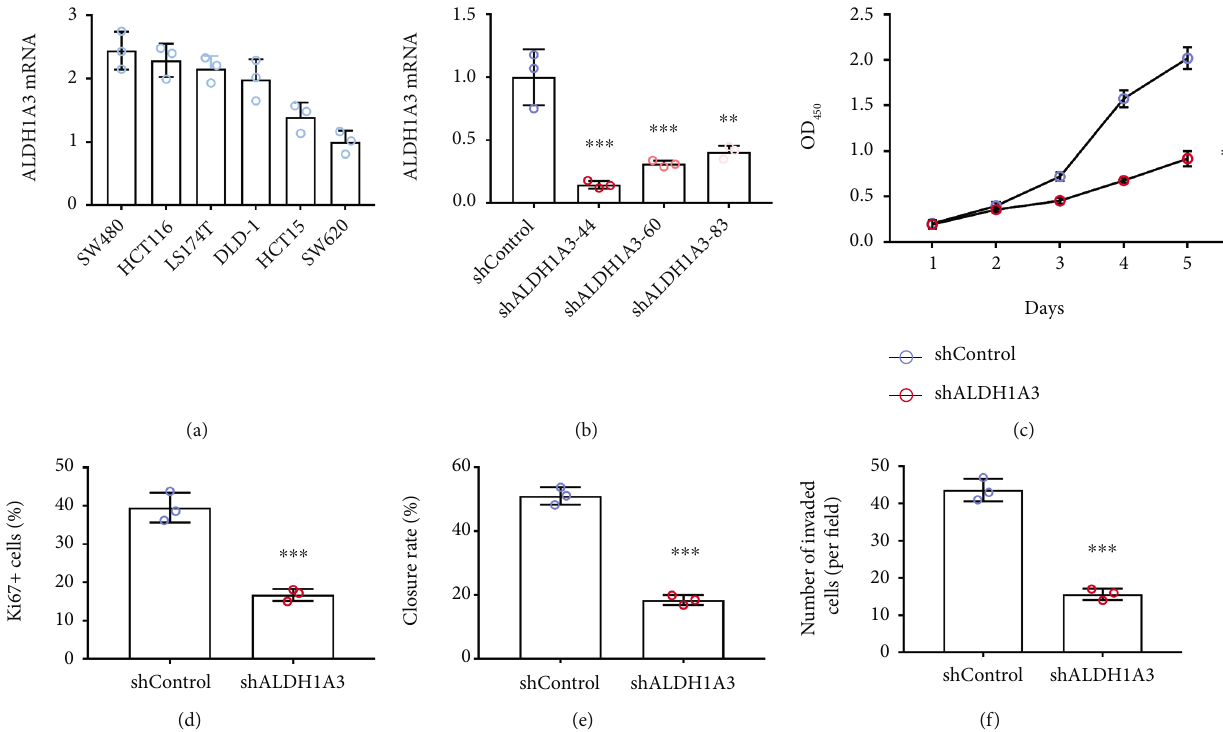
Figure 2: Knockdown of ALDH1A3 repressed CRC cell proliferation, migration, and invasion in vitro . (a) ALDH1A3 mRNA level in multiple CRC cell lines. (b) ALDH1A3 silencing e ffi ciency in SW480 cells by shRNAs TRCN0000027144 (shorted to 44), TRCN0000 027160 (shorted to 60), and TRCN0000027183 (shorted to 83) was veri fi ed by qPCR analysis. (c) The cell viability of ALDH1A3-silenced SW480 cells and the control cells was measured by CCK-8 assay. (d) Proliferation of SW480 cells was analyzed with Ki67 staining by fl ow cytometry. (e) The migration of ALDH1A3-silenced CRC cells was determined by wound healing assay. (f) The invasion of ALDH1A3-silenced CRC cells was analyzed by trans-well assay (3 wells per group).